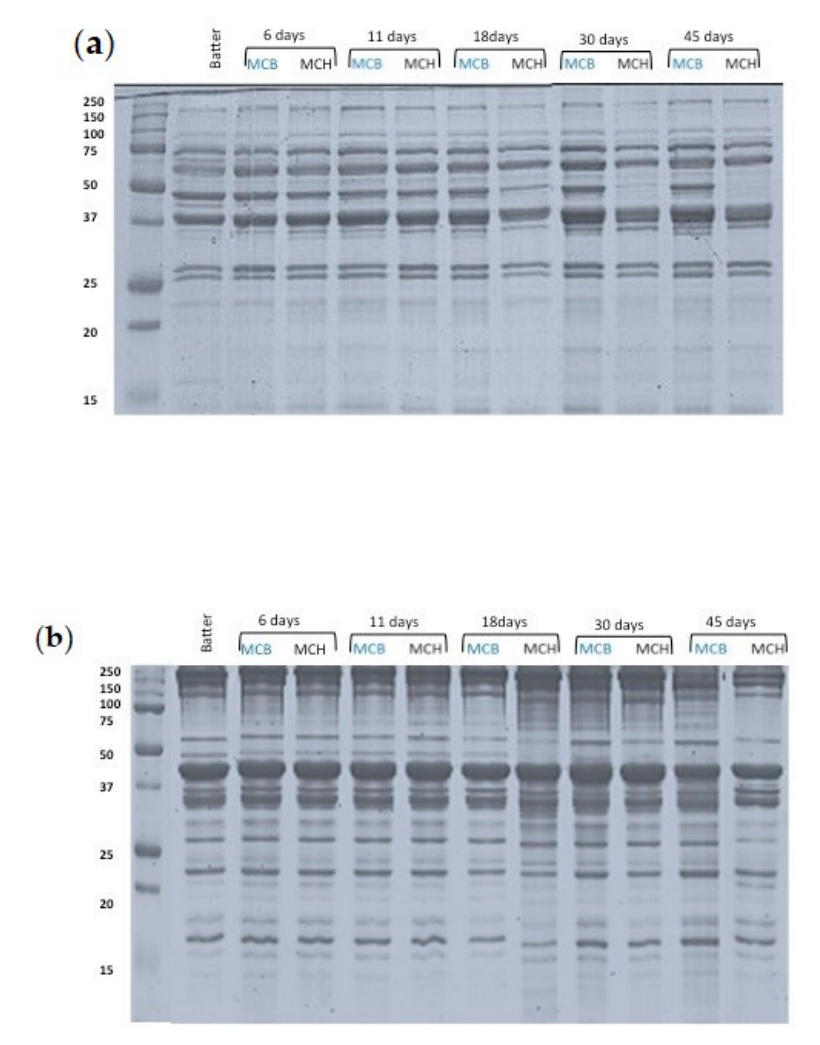
Figure 2. SDS-PAGE electrophoretic profiles of “ Mortadella di Campotosto ”-like sausages produced with beef (MCB) and hog (MCH) casings over time. Panel ( a ) sarcoplasmic fraction; panel ( b ) myofibrillar fraction. Batter: 0 days. Values on the ordinates refer to the marker and express the bands dimension in